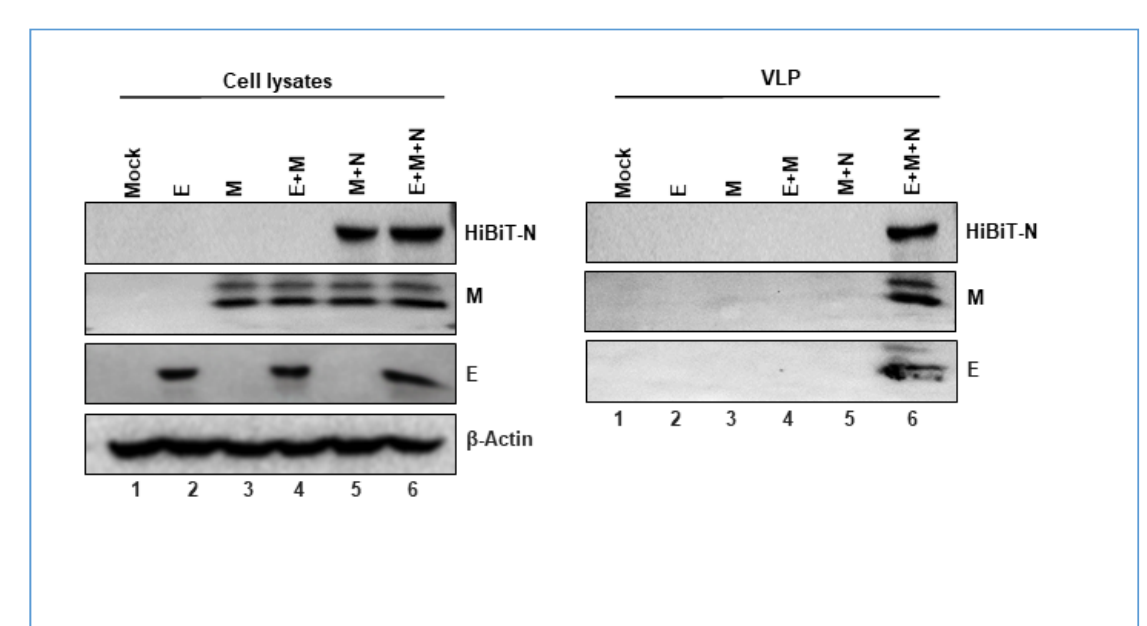
Figure 3. N proteins facilitate VLP production. The indicated plasmid co-transfections were performed, and 24 h later, cell lysates and SEC-purified VLPs were evaluated by WB for the presence of E, M, and N proteins.